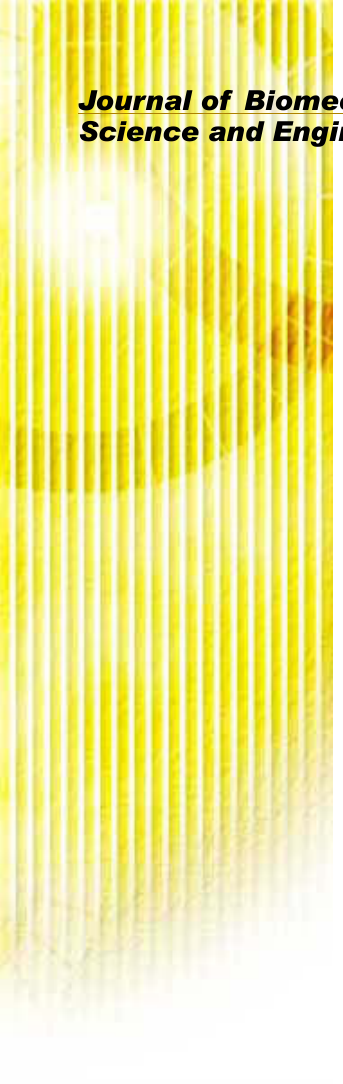
morphology were conducted for non-treated, intact specimens (Control group).